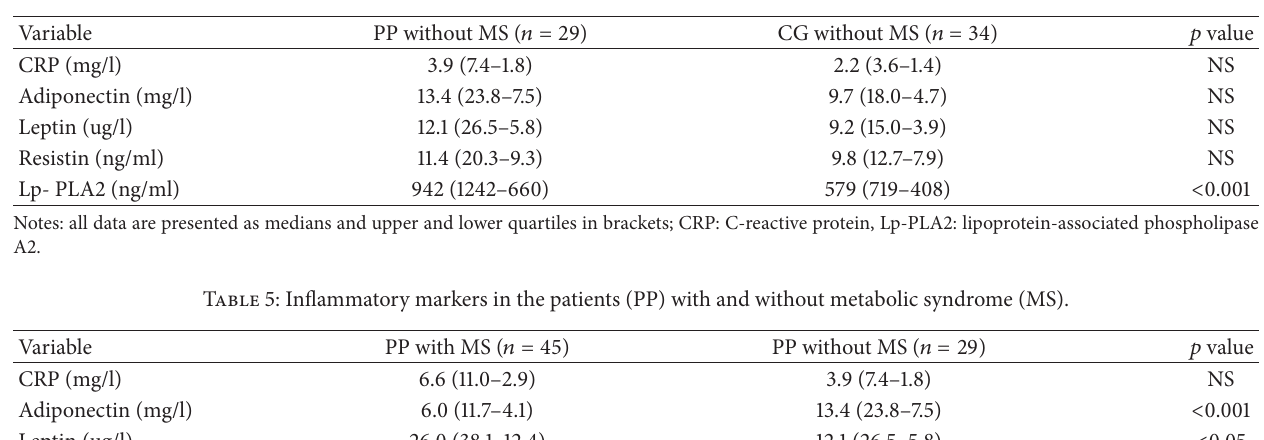
Table 4: Inflammatory markers in the patients (PP) and the controls (CG) without metabolic syndrome.